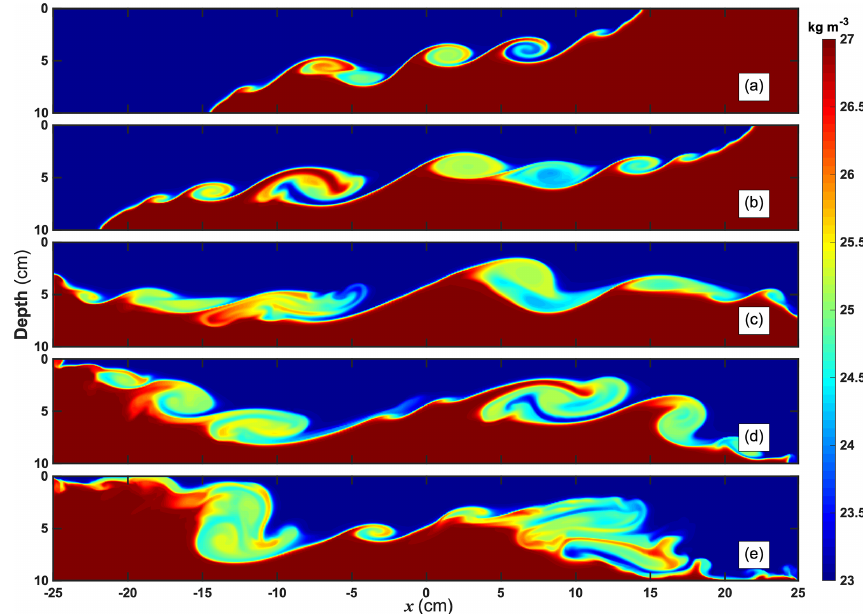
Figure 2. Density field evolution at t = (a) 5.0, (b) 7.5, (c) 10.0, (d) 12.5, and (e) 15.0s.